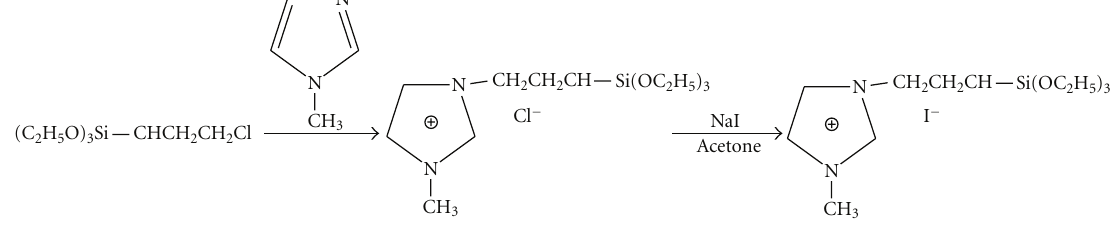
Scheme 1: Synthesis of TESPIm + I −